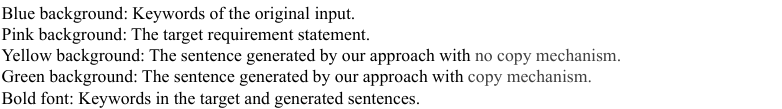
Figure 4. An example with or without the copy